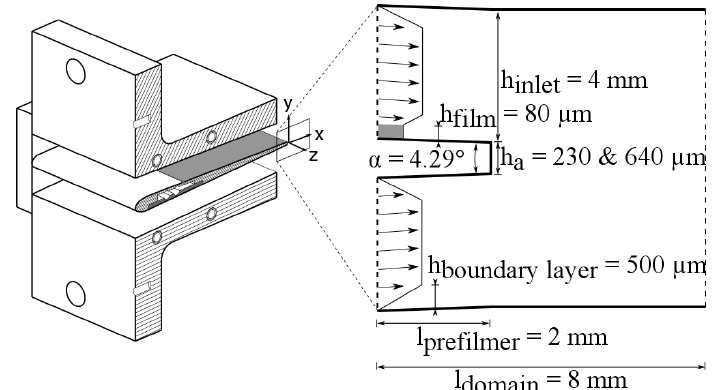
Figure 3. Experimentally investigated prefilmer (left) and corresponding computational domain